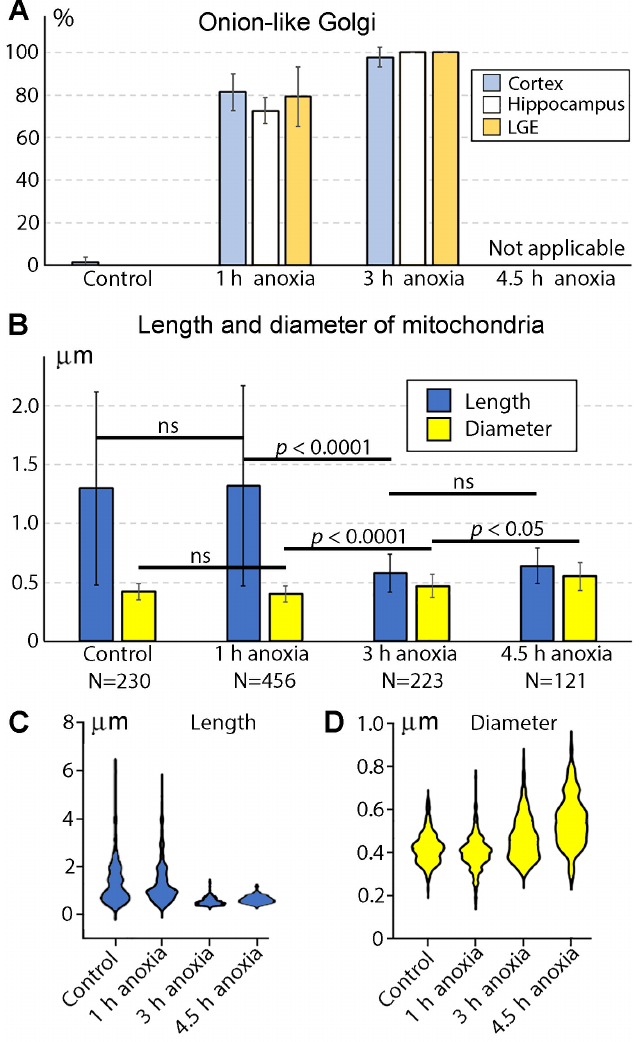
Figure 3. ( A ) Up-regulation of swirled onion-like GA in the anoxia-exposed E13 mouse embryo brains. Swirled GA are nearly absent in control animals. Normal GA are virtually absent after 3 h anoxia. After 4.5 h, even swirled GA are barely identifiable because of degradation of cytoplasm and organelles in many cells; that is why this time point was excluded from analysis. Percentages of swirled GA are expressed as mean ± SD for each spatiotemporal location (Table 1). ( B ) Morphometric characterization of mitochondria in mouse embryo cerebral SVZ fixed immediately after decapitation (control) and after 1, 3, and 4.5 h anoxia. Length and diameter of mitochondria are expressed as mean ± SD. Ns are numbers of analyzed 3D-reconstructed mitochondria. ( C , D ) Estimation plots for the length and diameter of mitochondria from control and anoxia-exposed mouse embryo cerebral cortex. Notice similarity between control and 1 h anoxia groups for both length and diameter. Notice also large difference between 3 h and 4.5 h groups from control and 1 h anoxia groups.